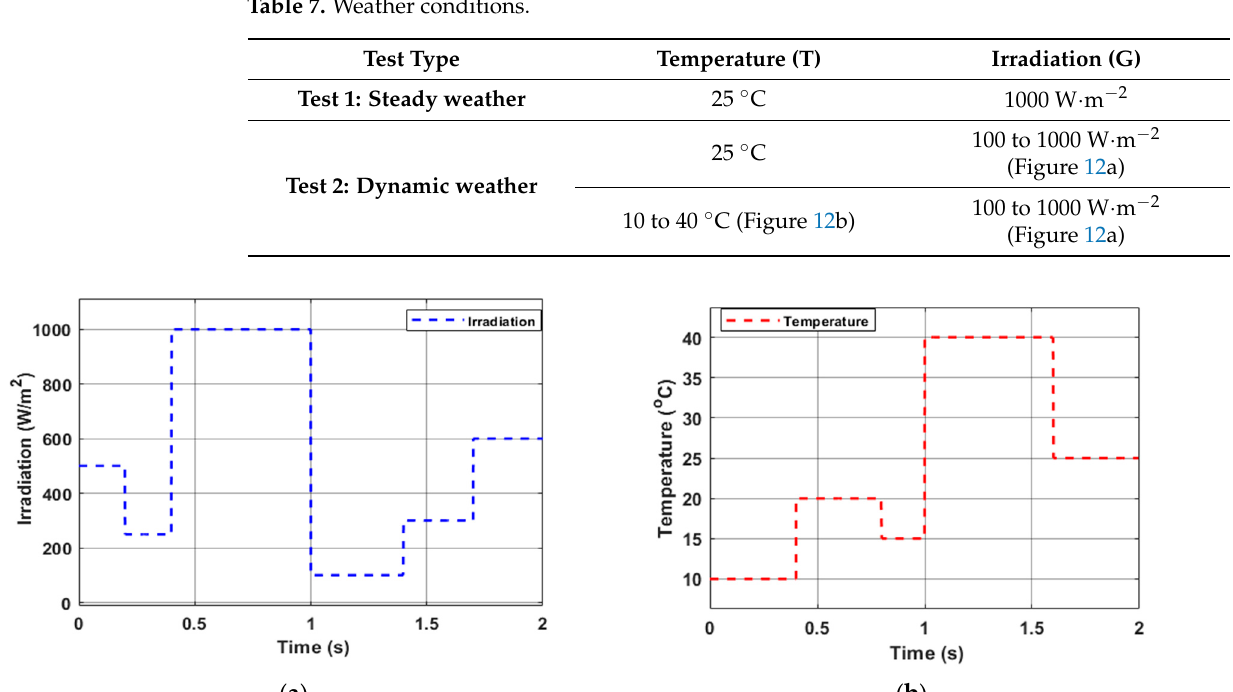
Figure 12. ( a ) Irradiation variation profile, ( b ) Temperature variation profile.